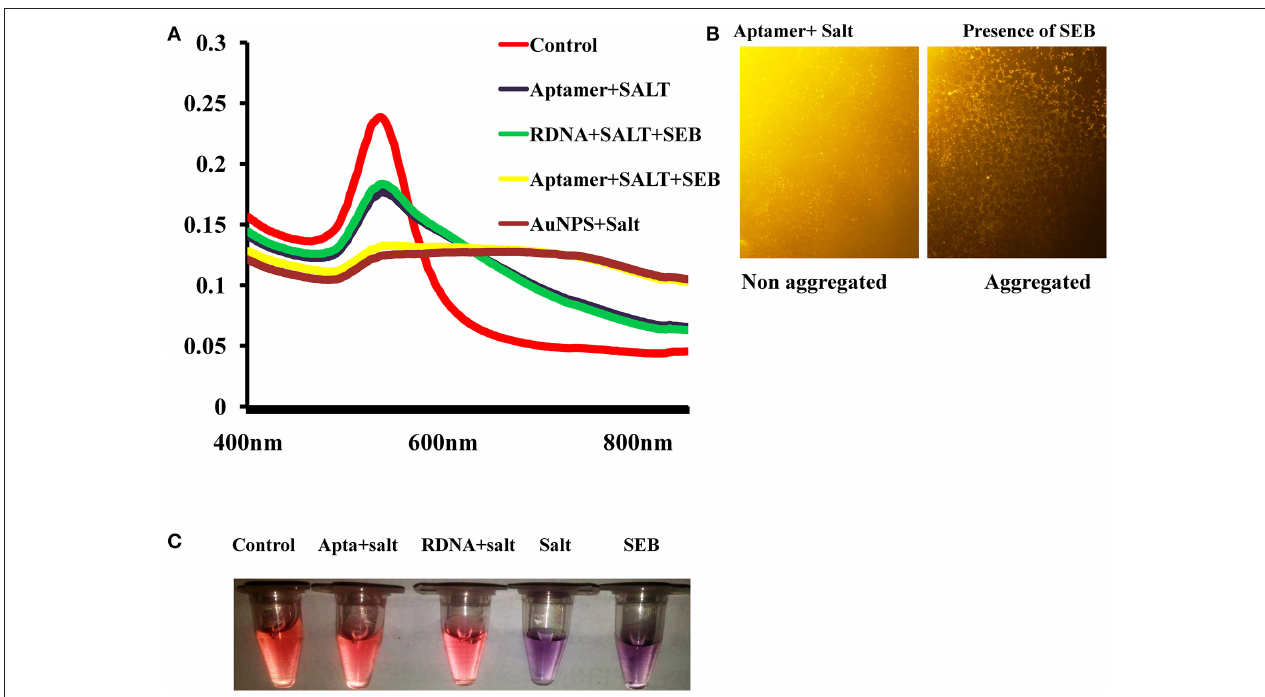
FIGURE 2 | Spectral characteristic and visual observation of AuNPs solutions in various conditions. (A) Absorption spectra of AuNPs solutions in various conditions. (B) Microscopic image of AuNPs/aptamer mixed solutions in presence and absence of toxin. (C) Visual observation of AuNPs solutions in various conditions.